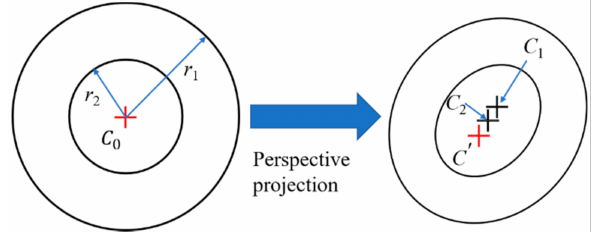
Figure 9. Perspective projection of central positioning ring of the coded target.